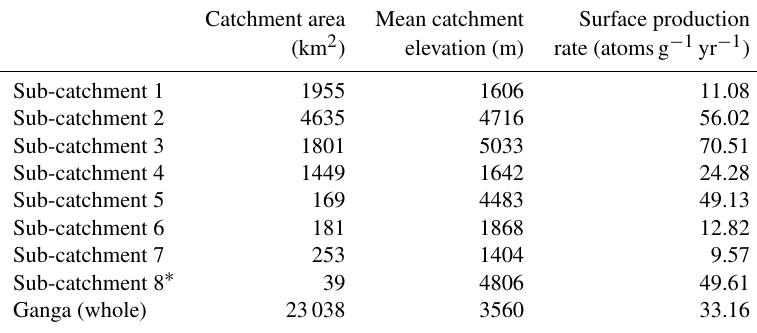
Table 2. Catchment area, mean catchment elevation and average 10 Be surface production rate for sub-catchments in the Ganga catchment.